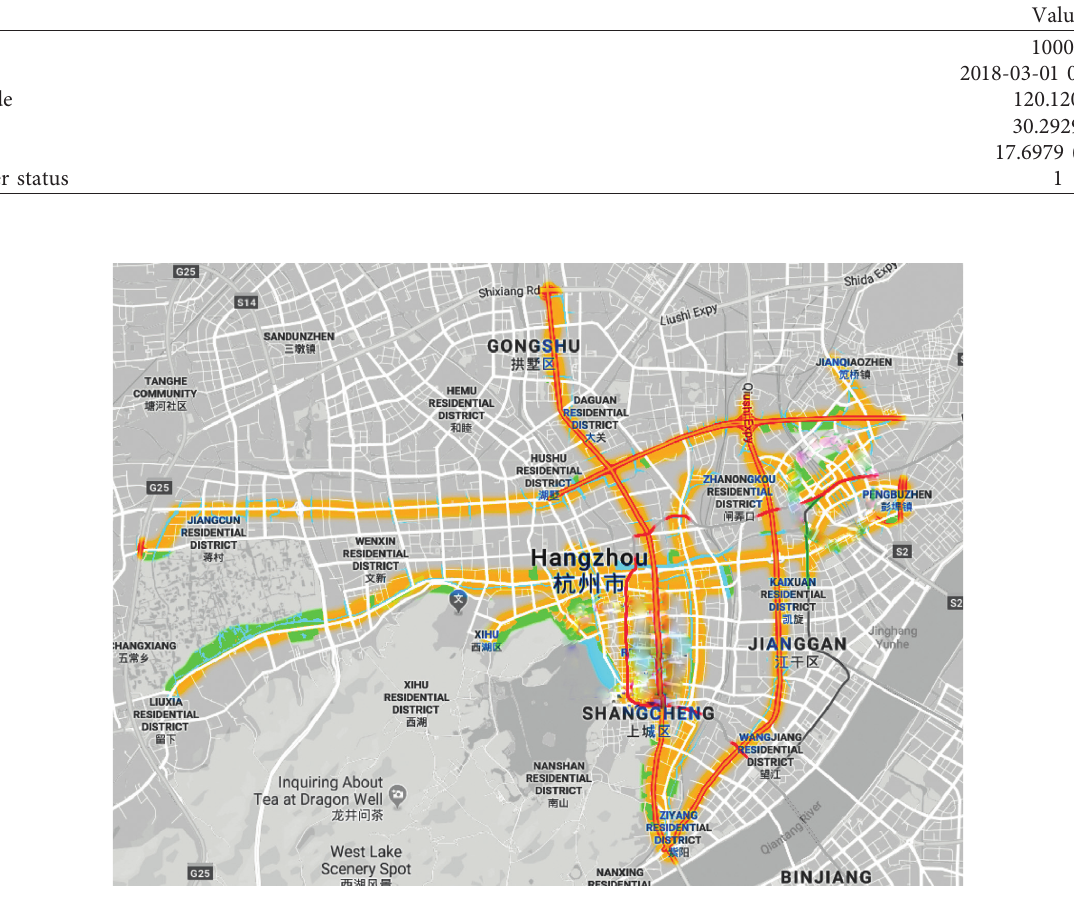
Figure 2: The road network diagram of Hangzhou city,